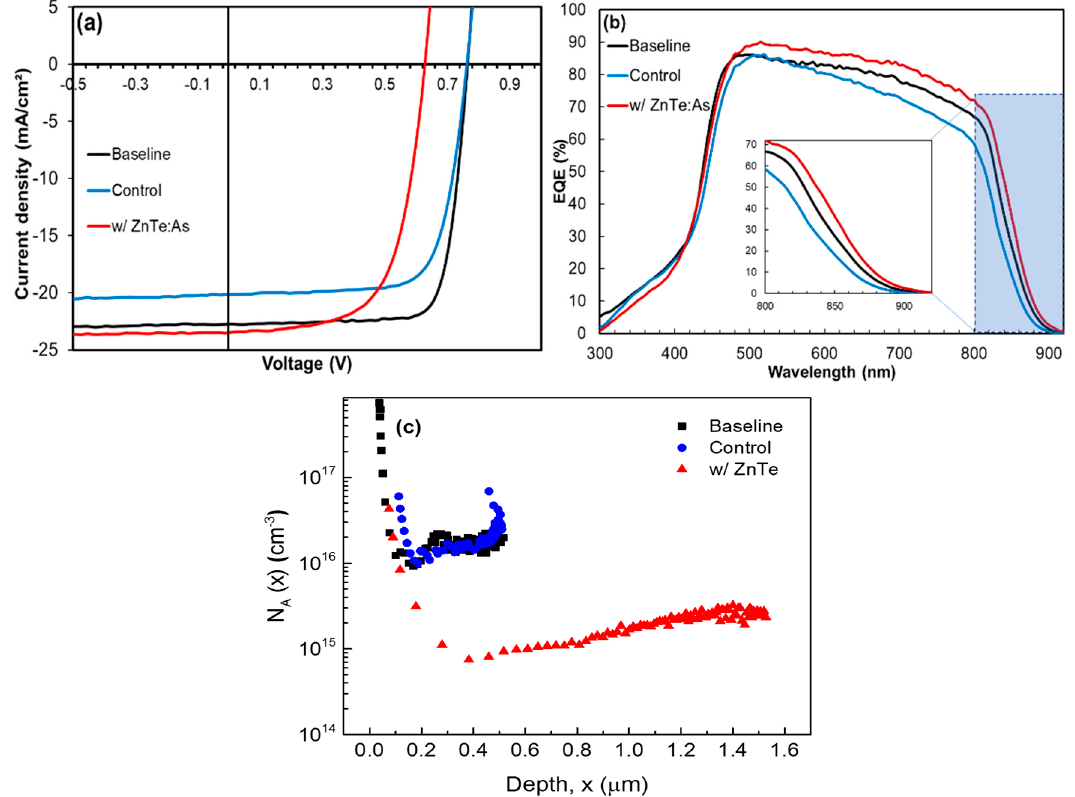
Figure 3. ( a ) Illuminated J-V curves ( b ) external quantum efficiency (EQE) spectra and ( c ) acceptor concentration profiles for: baseline, control, and ZnTe:As (with NO post-deposition treatment) back contacted devices.